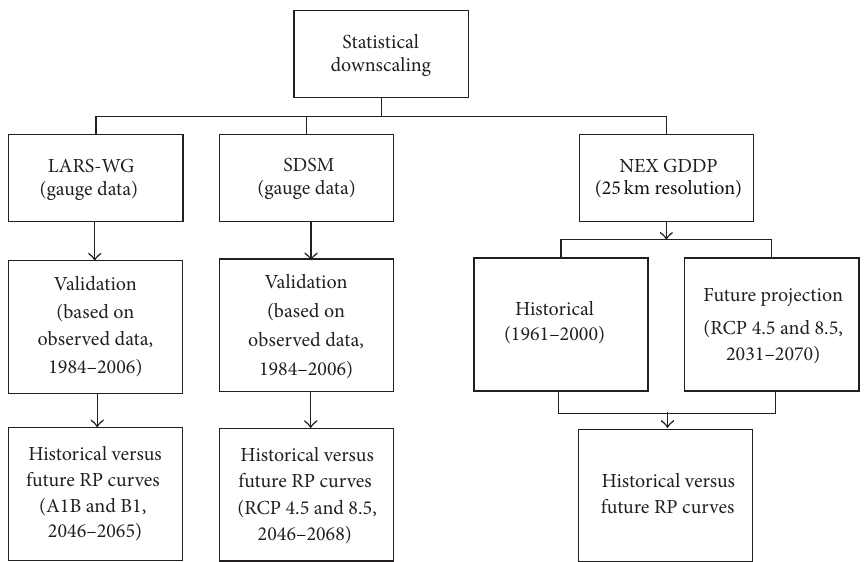
Figure 2: Methodology flowchart showing the framework comparing historical and future daily rainfall RP curves via three different components: LARS-WG, SDSM, and the NEX-GDDP gridded